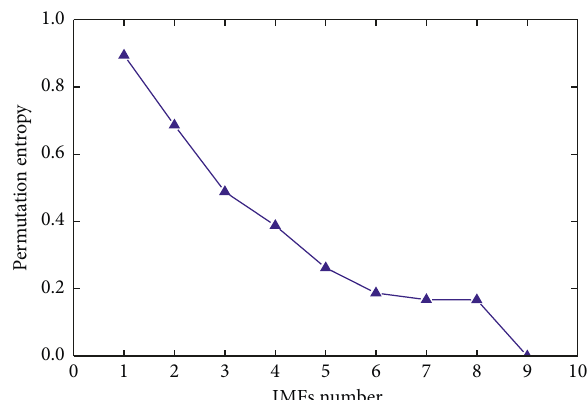
Figure 8: PE distribution of the CEEMDAN decomposed